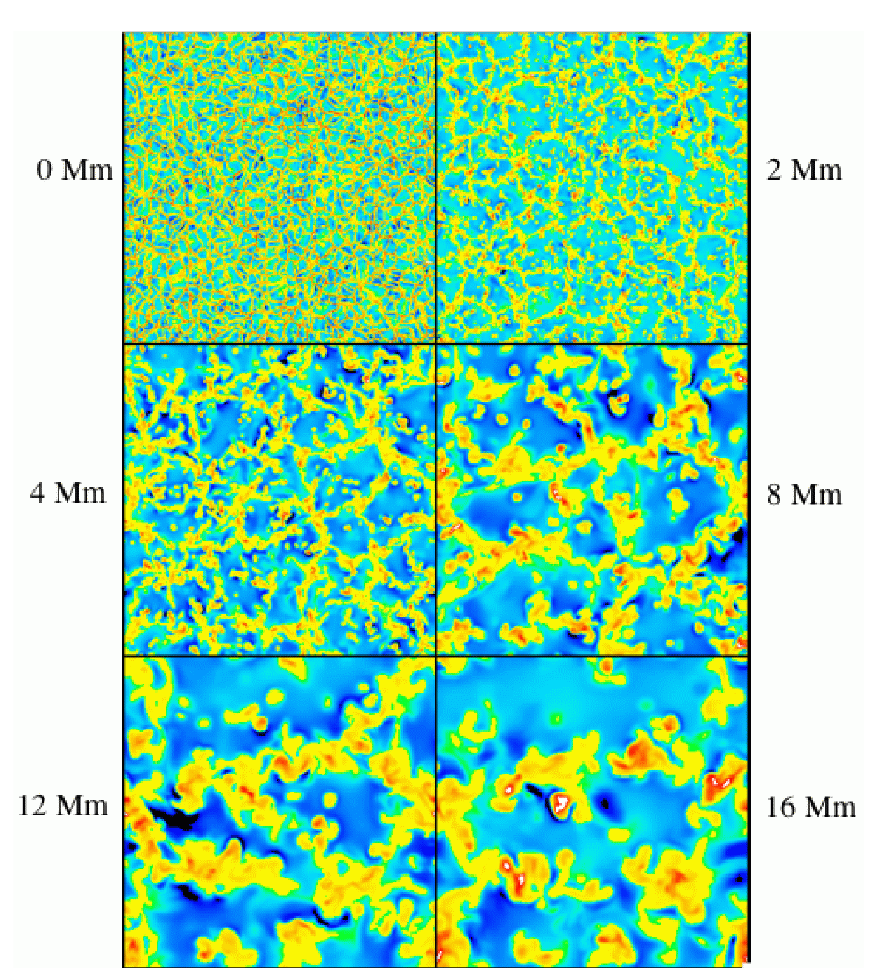
Figure 35: Vertical velocity patterns from a solar-like model of convection. Blue and green indicate upflows whereas yellow and red indicate downflows. The different panels show the velocity distribution at various depths of the model. The horizontal extent of the computation domain is 48 × 48 Mm 2 and the bottom boundary is at 20 Mm below optical depth unity. Image reproduced with permission from Stein et al. (2011), copyright the